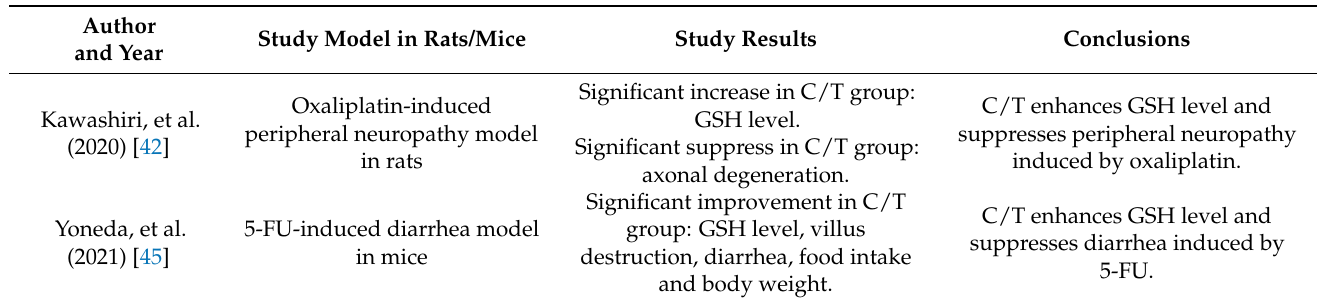
Table 4. Basic research of cystine/theanine for adverse events of anticancer